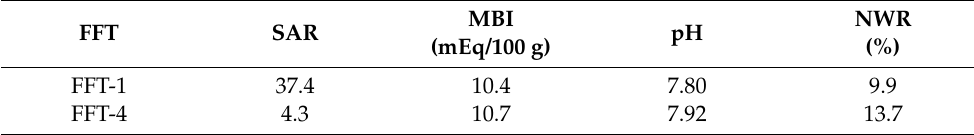
Table 7. The comparison of SAR, MBI, pH, and NWR between FFT-1 and FFT-4.